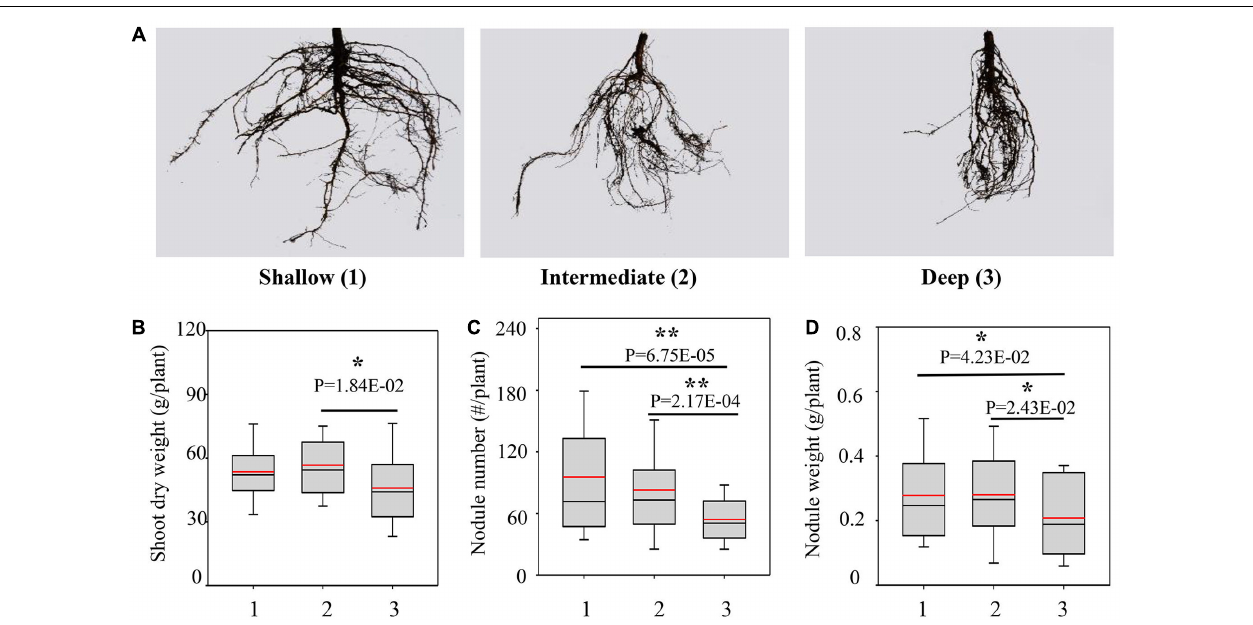
FIGURE 2 | Biological nitrogen fixation traits as affected by RA in the RILs. (A) Representative pictures of root systems from different groups; 1, 2, and 3 represent the group of RILs with shallow, intermediate and deep RA, respectively; (B) SDW; (C) nodule number; (D) nodule weight. The black and red lines, lower and upper edges, and bars up or low side the boxes represent median and mean values, 25th and 75th, 5th and 95th percentiles of all data, respectively. Asterisks indicate the significance of differences between shallow, intermediate and deep group through Student t -test at 5% ( ∗ ) and 1% ( ∗∗ ) level.